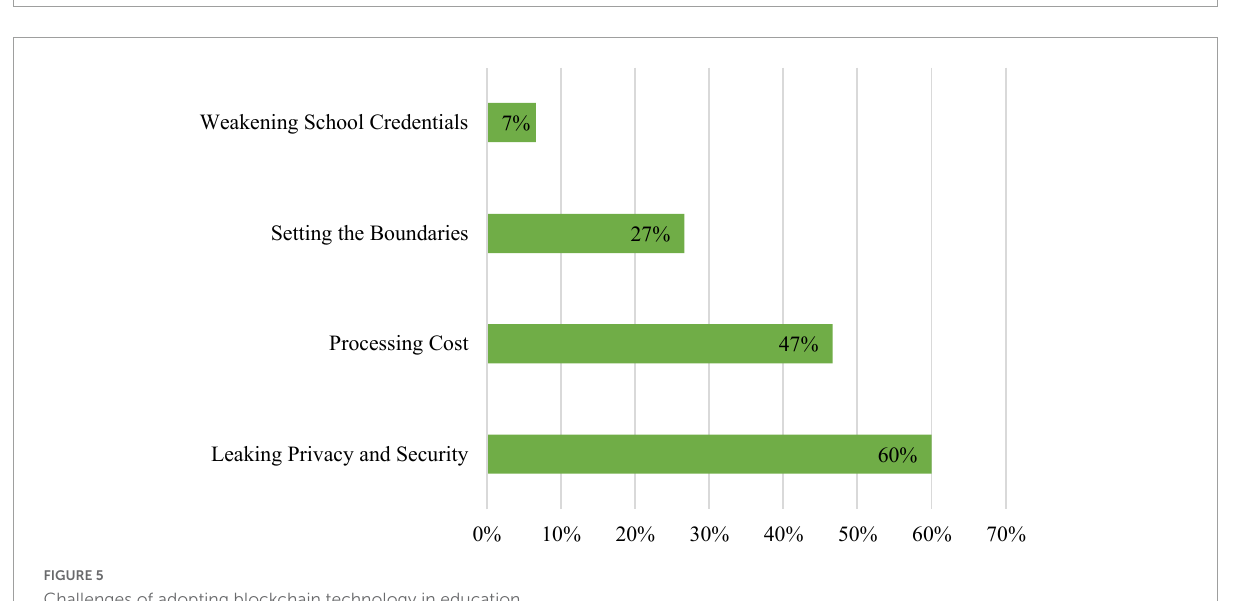
FIGURE4 Benefits of adopting blockchain technology in education.